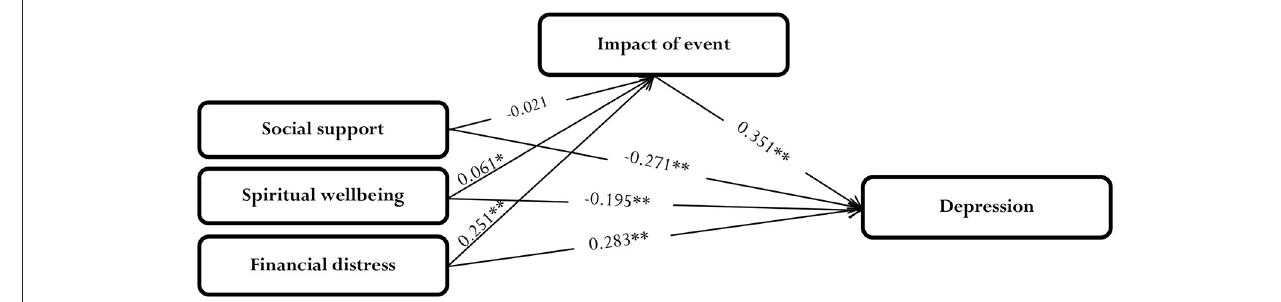
FIGURE 1 | Path diagram. ** p < 0.01, * p < 0.05.